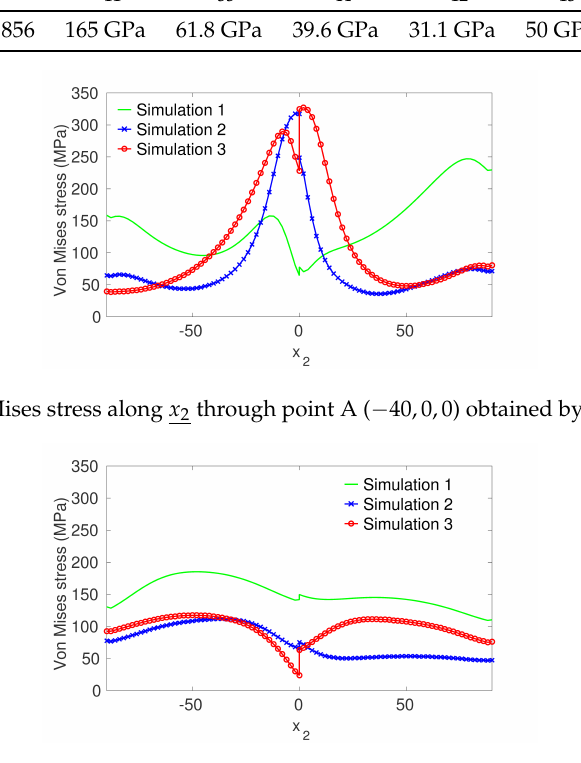
Figure 7. Profiles of Von Mises stress along x 2 through point B (0,0,0) obtained by FE simulations 1, 2 and 3.